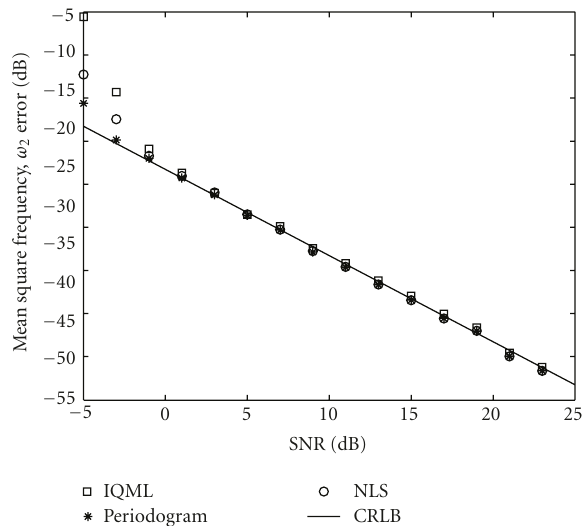
Figure 26: MSE for ν of 2D single complex sinusoid.